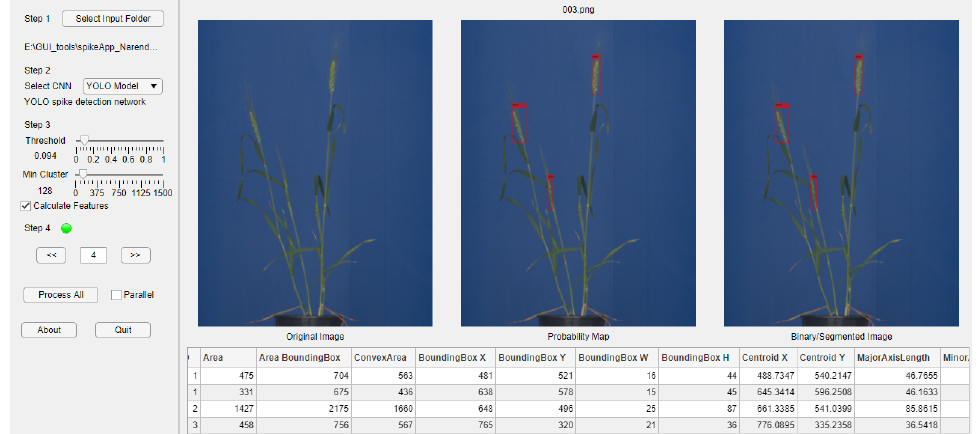
Figure 11. Screenshot of the SpikeApp tool for demonstration of DNN/ANN performance on detection, segmentation and phenotyping of grain spikes. On the left-hand side of the tool, the control and parameter section can be found, while on the right, the output area located. On the right, below the images, a table with the extracted features for all images is provided to the user for quick